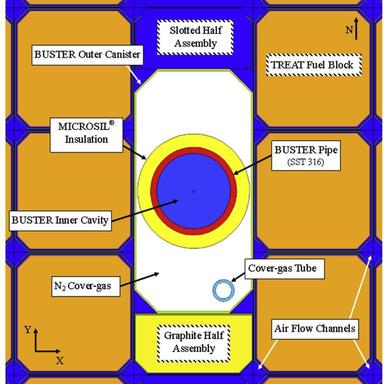
Magnified Horizontal View of BUSTER.